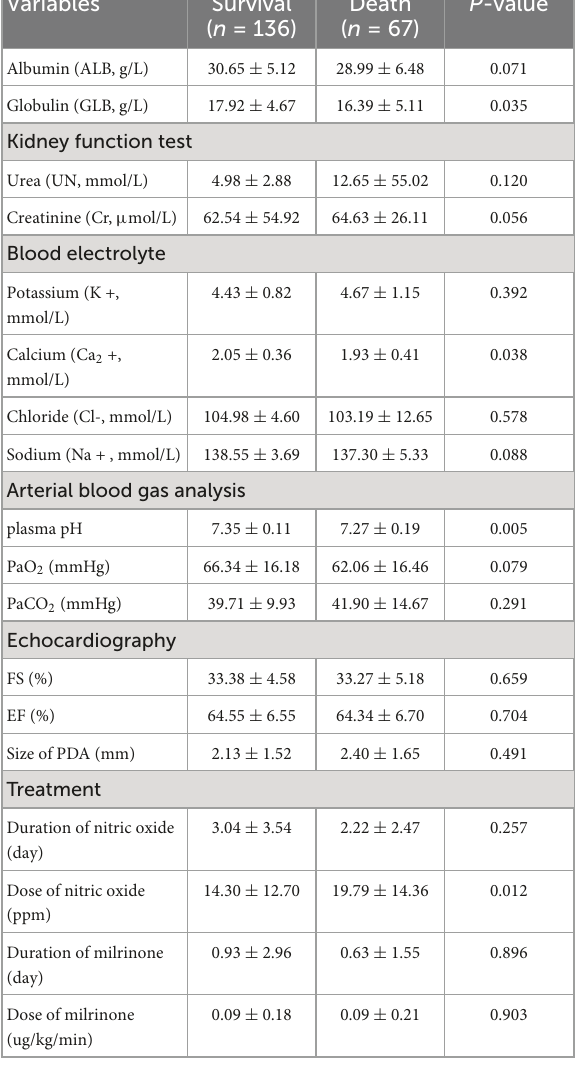
ICP,intrahepaticcholestasisofpregnancy. *CHD include atrial septal defects, ventricular septal defects, pulmonic stenosis, aortic stenosis, coarctation of the aorta, bicuspid aortic valve stenosis, subaortic stenosis, persistent truncus arteriosus, pulmonary venous connection, tetralogy of Fallot, hypoplastic left heart syndrome, hypoplastic right heart syndrome, Mitral